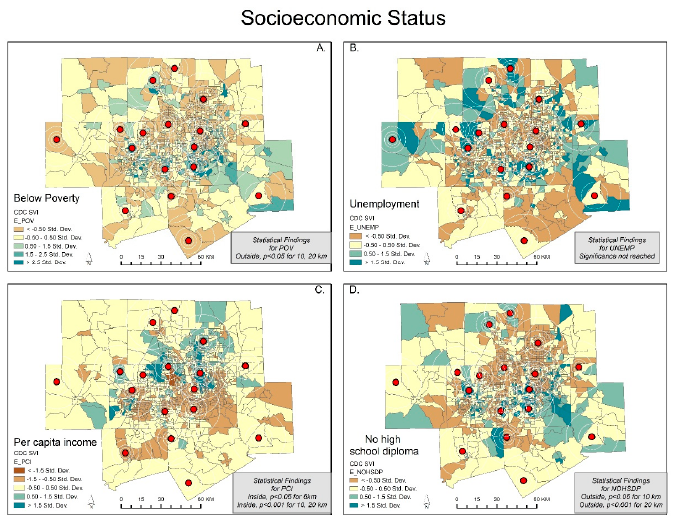
Figure 1. Dallas—Fort Worth: SD classification scheme of social variables for socioeconomic status. The CDC/ATSDR SVI variables include Figures; ( A ) below poverty; ( B ) unemployment; ( C ) per capita income; ( D ) no high school diploma.